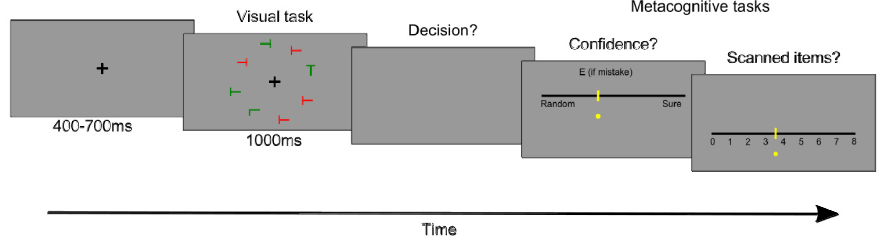
Fig 1. Example trial sequence. Participants have to search for a target (L or X) amongst distractors (T) and report its color. Then, they indicate their confidence in this decision and the number of items scanned during the search process.